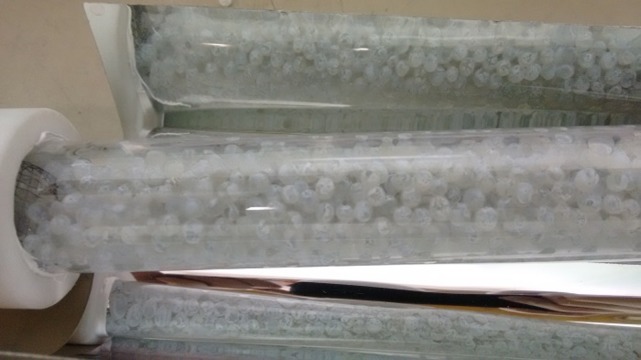
Glass spheres coated with TiO2-400 °C, filling borosilicate tubes in the CPC reactor.